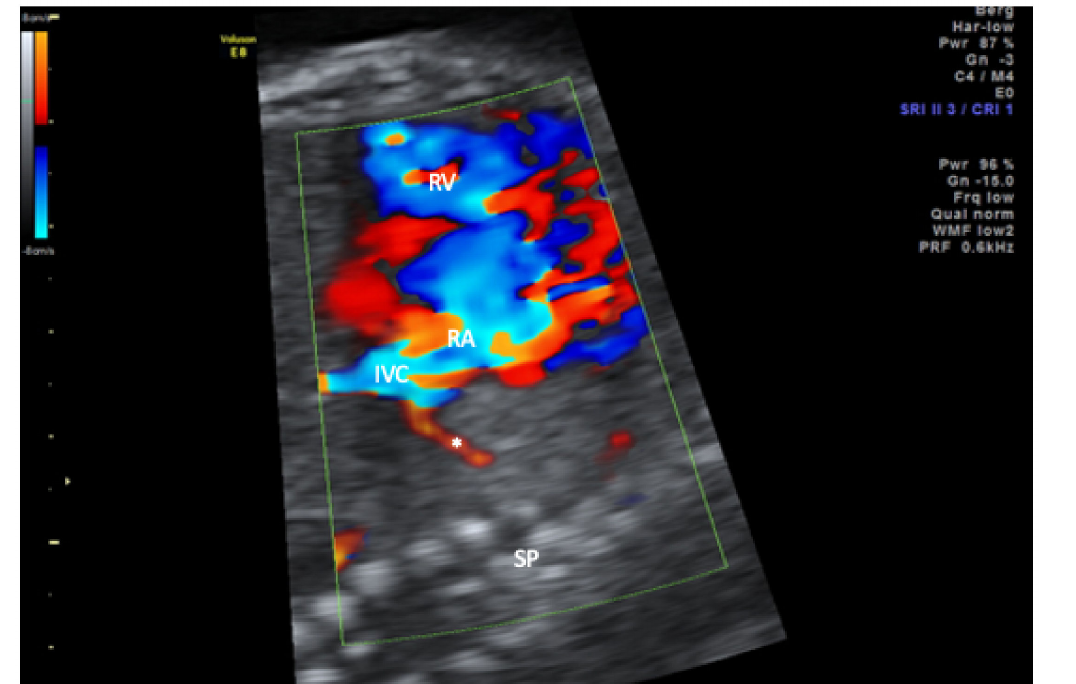
Figure 3. Sagittal view of the thorax in color-mode demonstrating the scimitar vein (asterisk) draining into the inferior vena cava (IVC) in close proximity of the right atrium. RA, right atrium; RV, right ventricle; SP,